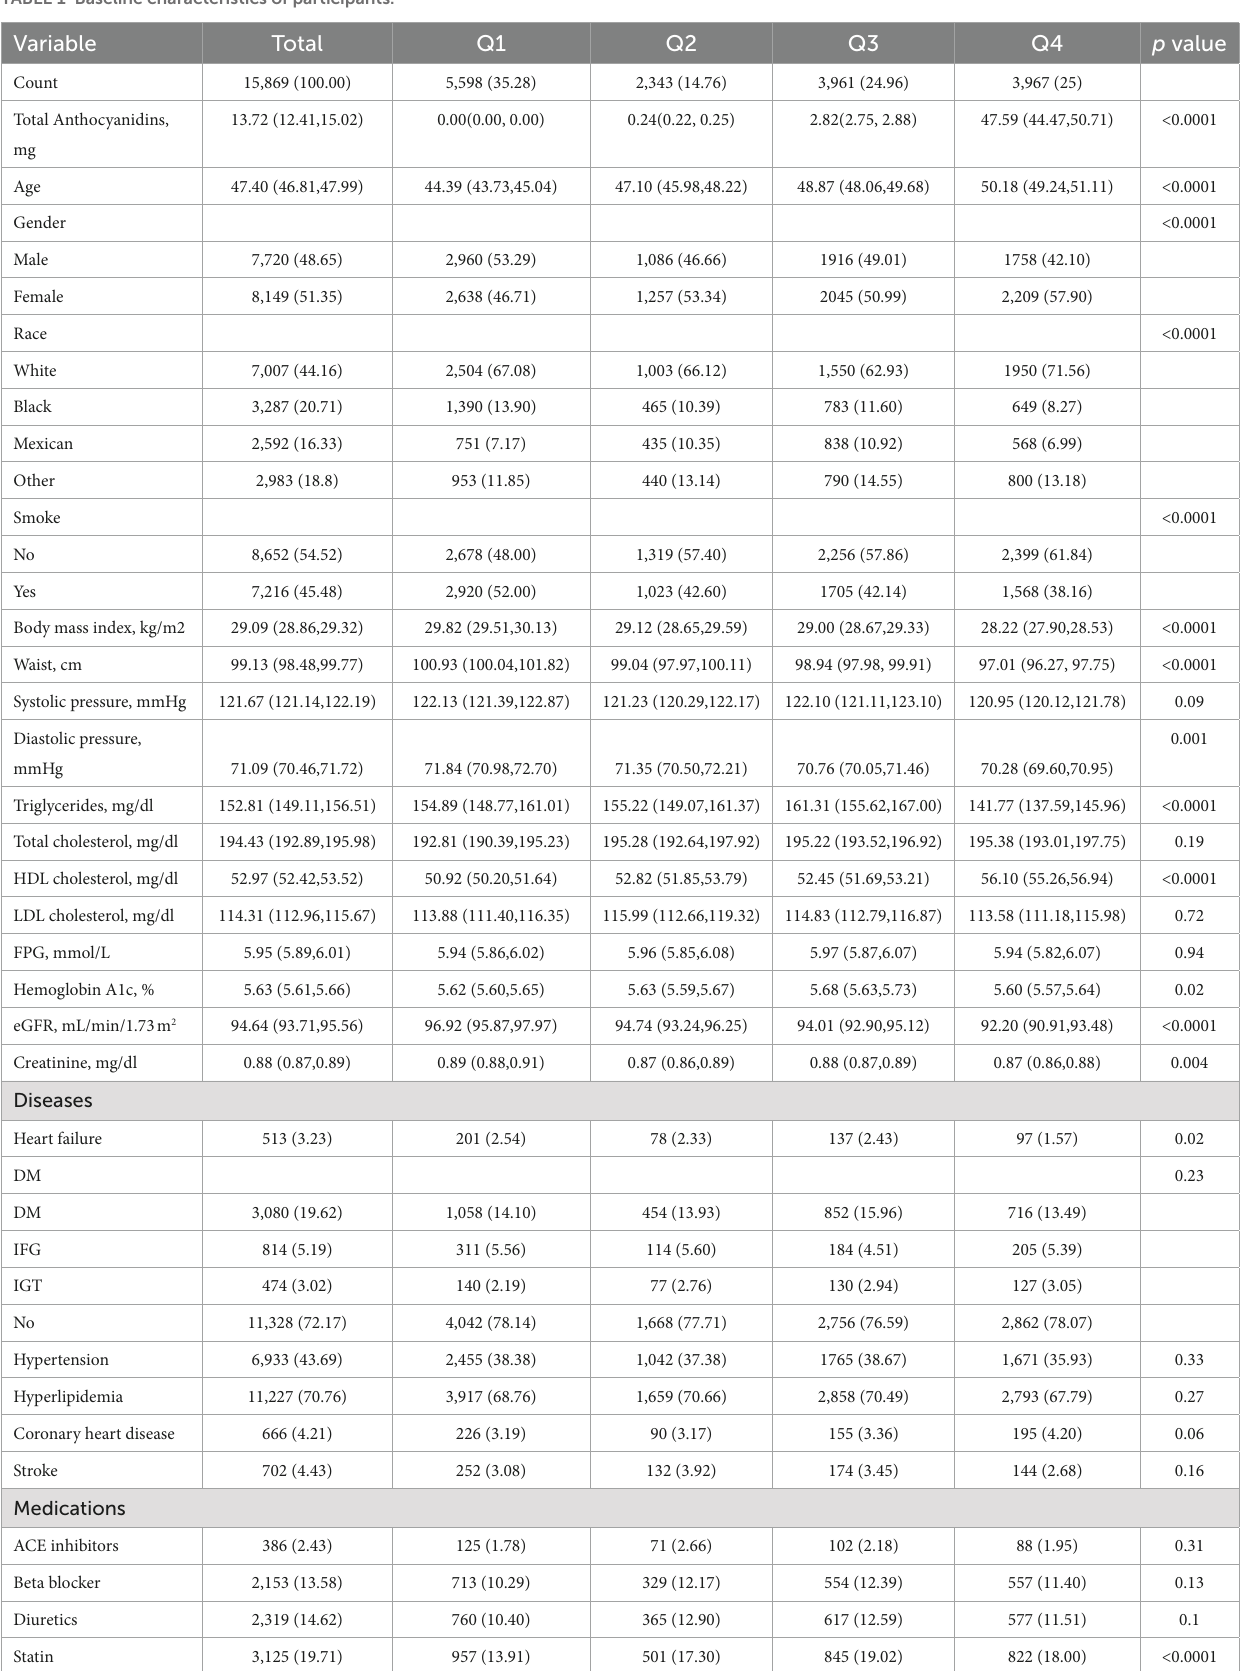
TABLE 1 Baseline characteristics of